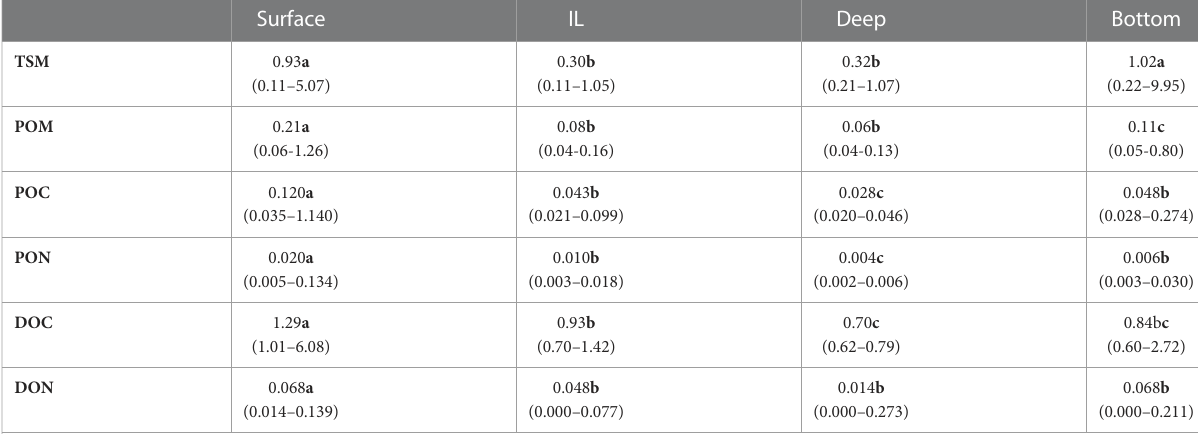
TABLE 3 Median (min-max) concentrations (mg/L) of particulate and dissolved organic matter in the LSLE for 2016 – 17. Surface IL Deep